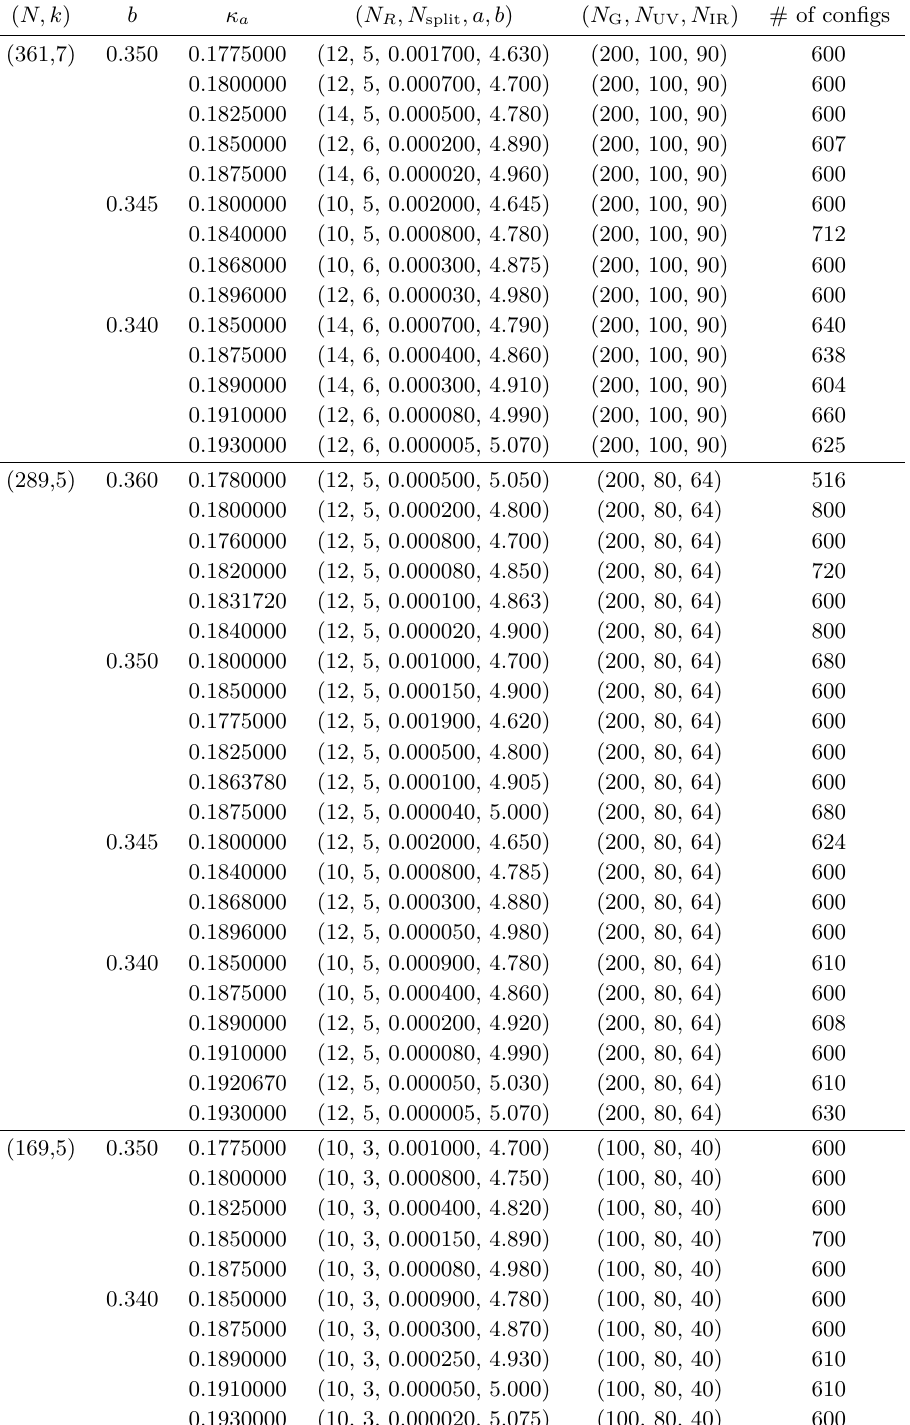
Table 7. Data sample: for each value of N and twist factor k , we list the bare coupling b , the adjoint hopping parameter κ a , the set of RHMC hyper-parameters used in the generation of configurations and the final number of configurations for each